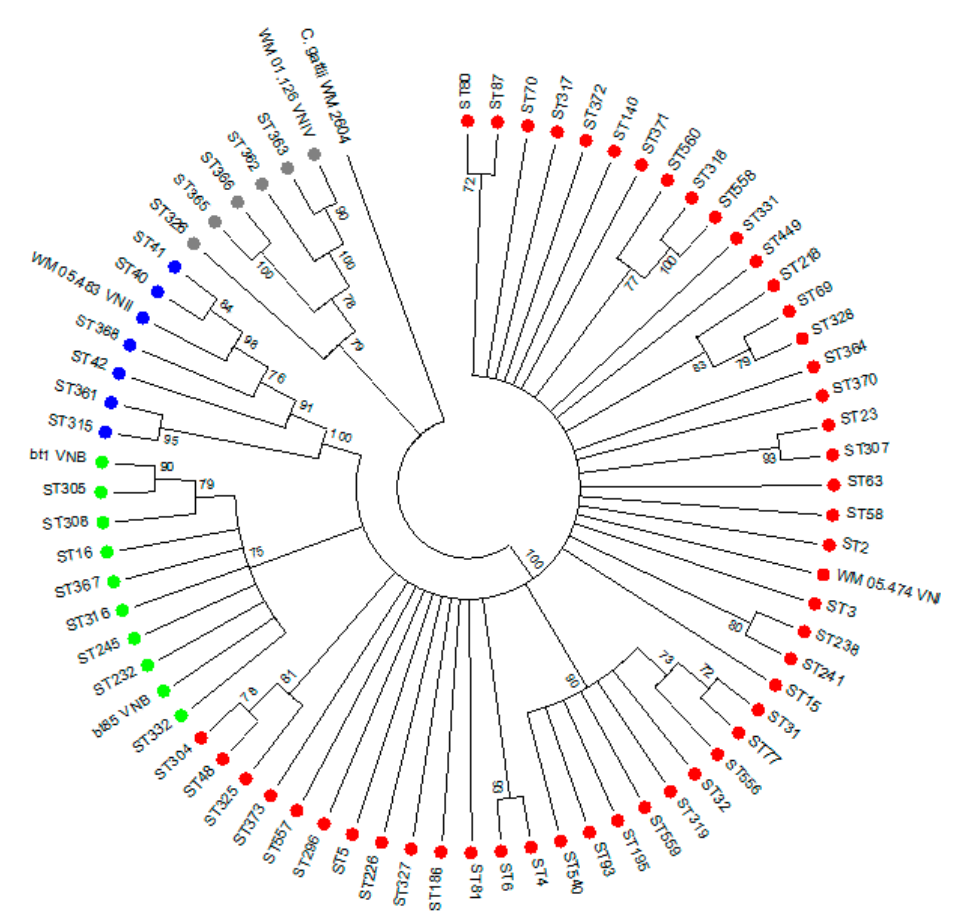
Figure 1. Neighbor joining phylogenetic tree showing clustering of molecular types for 67 different sequence types (STs) from 251 South African clinical Cryptococcus neoformans isolates. Cryptococcus gattii WM 2604 serves as the outgroup. Red circles indicate the STs with the VNI molecular type, blue circles indicate the STs with the VNII molecular type, green circles indicate the STs with the VNB molecular type, and grey circles indicate the STs with the VNIV molecular type. Bootstrap values are shown next to the branches.